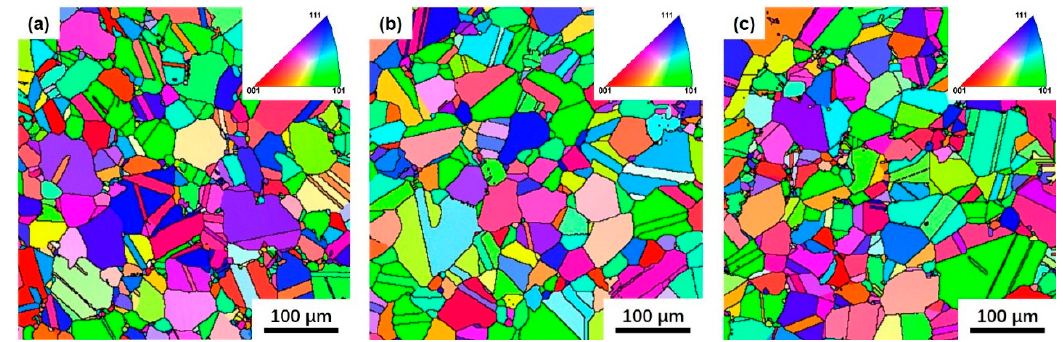
Figure 3. The color map of grains after different heat treatments. ( a ) Furnace cooling; ( b ) Air cooling; ( c ) Oil quenching.